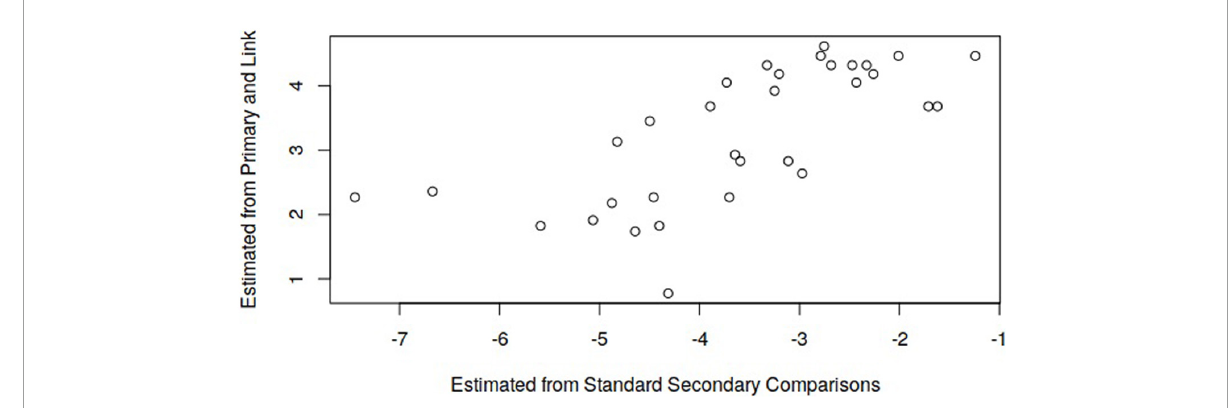
FIGURE3 Location estimates of the link set from scaling of independent data sets in the simulation study.